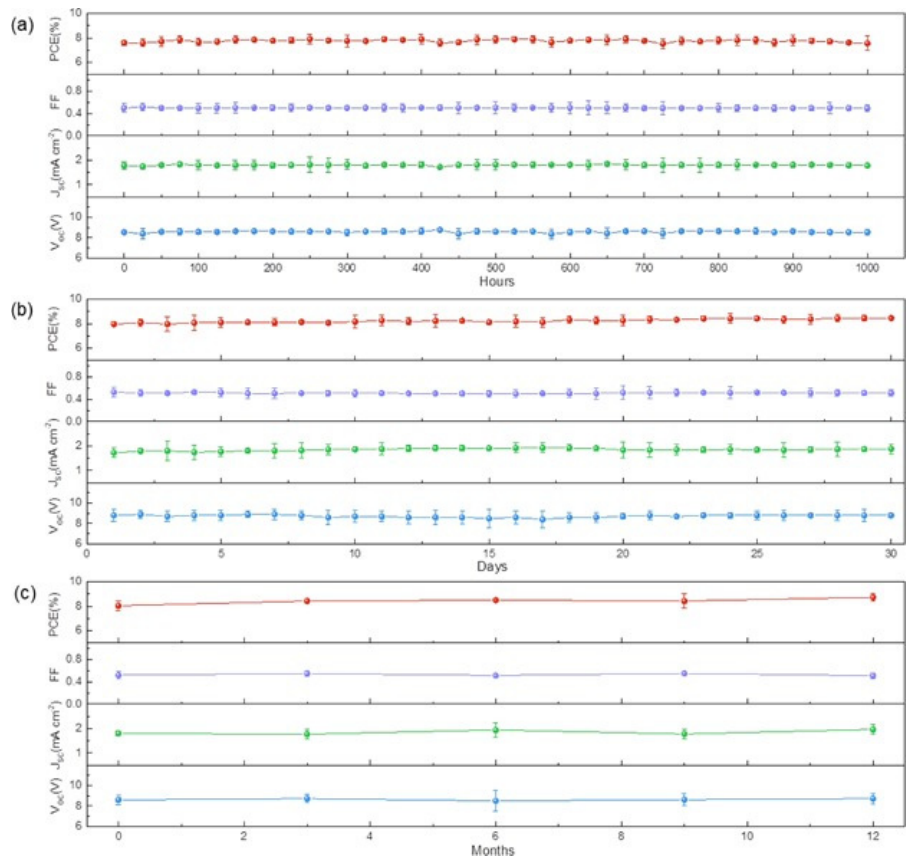
Figure 17. The evolution of the average photovoltaic parameters of three PSCs along with their standard deviations under different conditions: ( a ) at 100 mW/cm 2 , ( b ) during outdoor aging in Wuhan, China, and ( c ) in the dark for 1 year [96]. (Reproduced from Ref. [96], 10.1002/solr.201600019, with permission.)